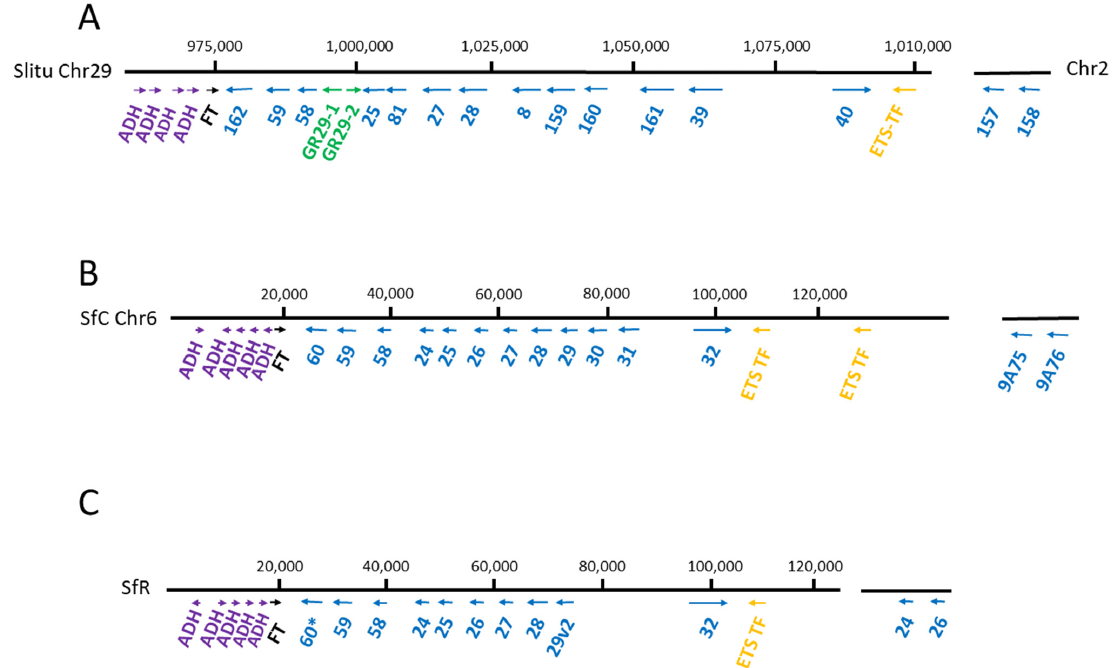
Figure 1. CYP9A cluster in the genome of S. litura ( A ), S. frugiperda corn strain ( B ) and S. frugiperda rice strain ( C ). Numbers in blue correspond to CYP9A genes. Arrows correspond to gene orientation, ADH: alcohol dehydrogenase, FT: fucosyl transferase, EST TF: E26 transformation specific transcription factor, * pseudogene.